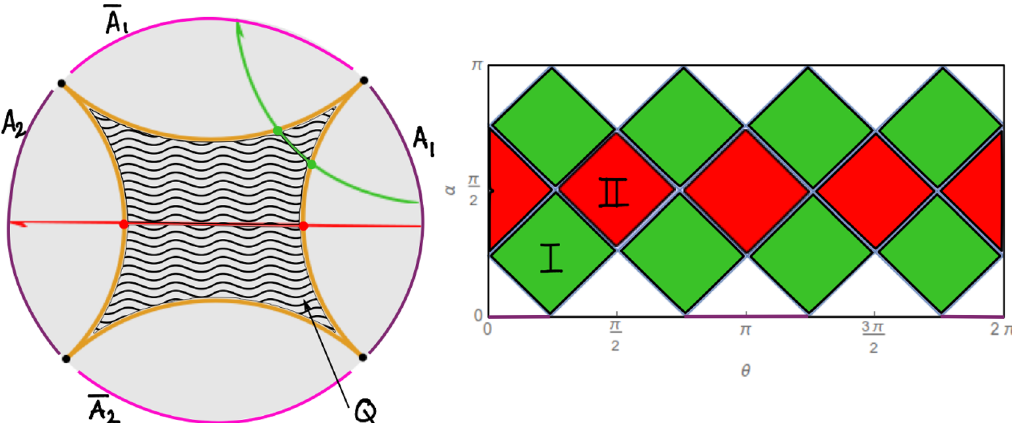
Figure 14. The region Q is the causal shadow emerging for two boundary intervals (purple) A 1 ∪ A 2 . The region K Q ⊂ K is the colored region in K ( right panel). There are two inequivalent types of geodesics passing through Q , indicated by the green and red squares in K . All squares of one color contribute equally. Hence we restrict our integration domain to one square of each color, labelled I and II ,